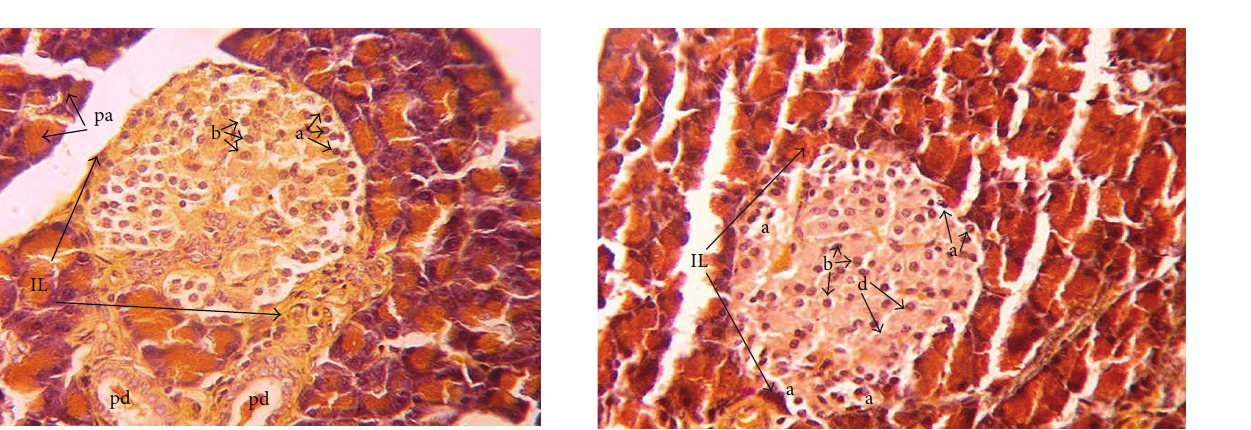
Figure 5: Photomicrograph of pancreas section of normal rat off- spring after two weeks of birth illustrating intact islets of Langerhans (IL) with many beta cells (b). Alpha (a) cell, and delta (d) cells are clearly observed ( × 400).